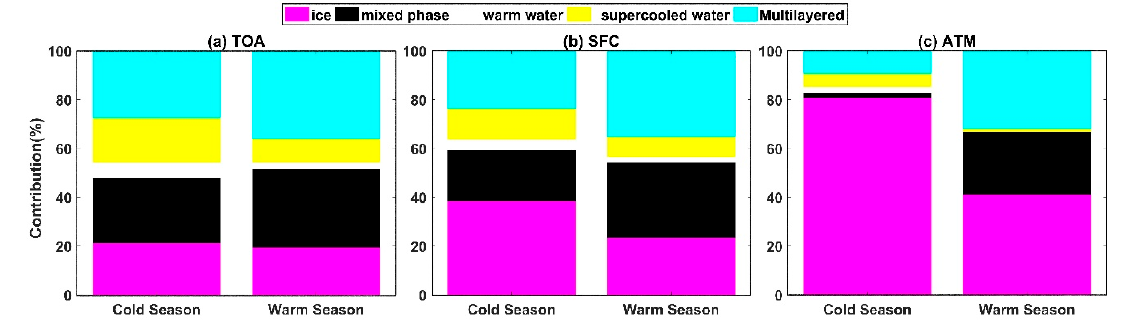
Figure 6. Four-year cloud radiation contribution of different cloud phases at the TOA, ATM, and SFC over the TP. (( a ) TOA indicates the top of the atmosphere, ( b ) SFC indicates the surface, and ( c ) ATM indicates the interior of the atmosphere. Here, ice clouds, water clouds, and mixed-phase clouds refer to the case of single-layer clouds).